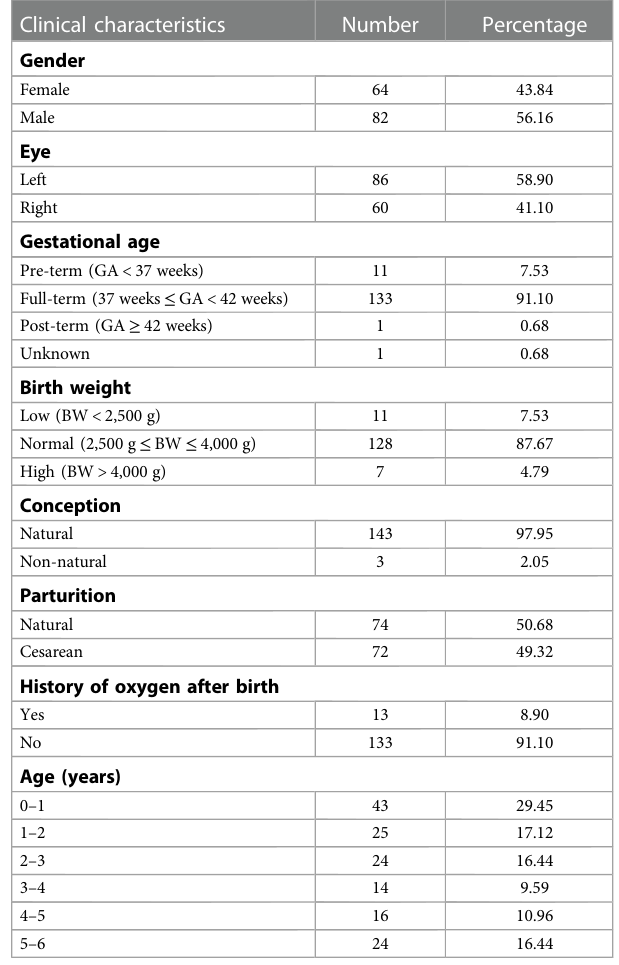
TABLE 2 the clinical characteristics of included children ( n =146).